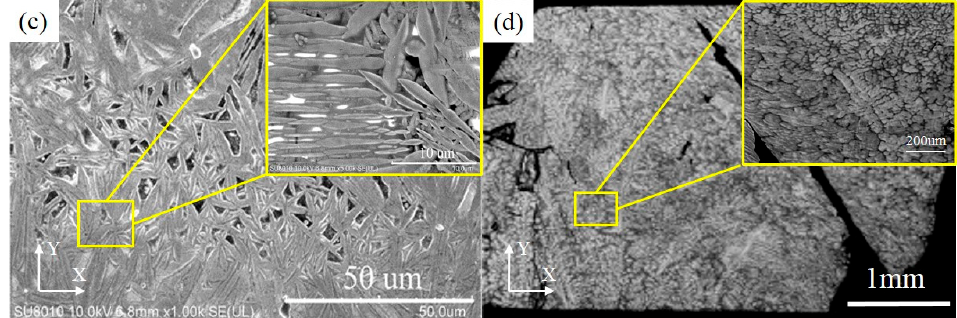
Figure 6. Different magnification figures of HEA pattern grain by scanning electron microscope (SEM) on XY plane. ( a ) Pattern grain figure in this study. ( b ) As-cast NbMoTaW HEA grain figure [12]. ( c ) Pattern grain figure with a further amplification in this study. ( d ) As-cast NbMoTaW HEA grain figure with a further amplification [12].